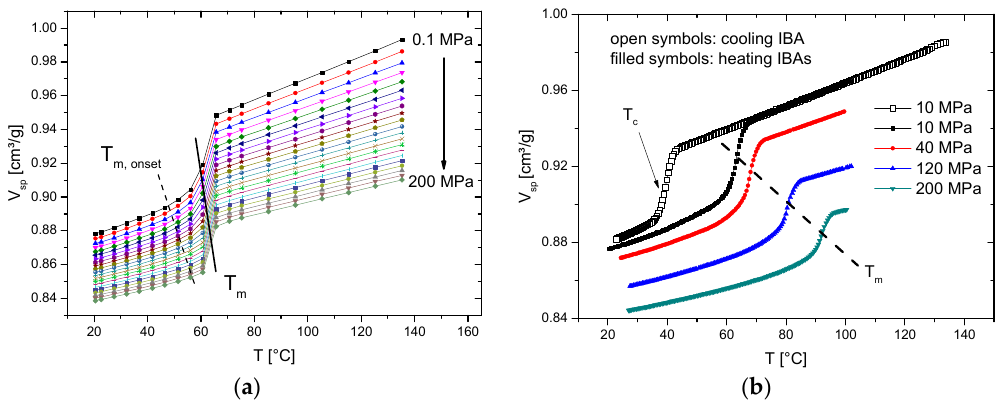
Figure 5. Crystallization of PCL analyzed by ( a ) isothermal standard mode (ITS) und ( b ) isobaric mode (IBA) runs (0.5 K/min). (IBA) runs (0.5